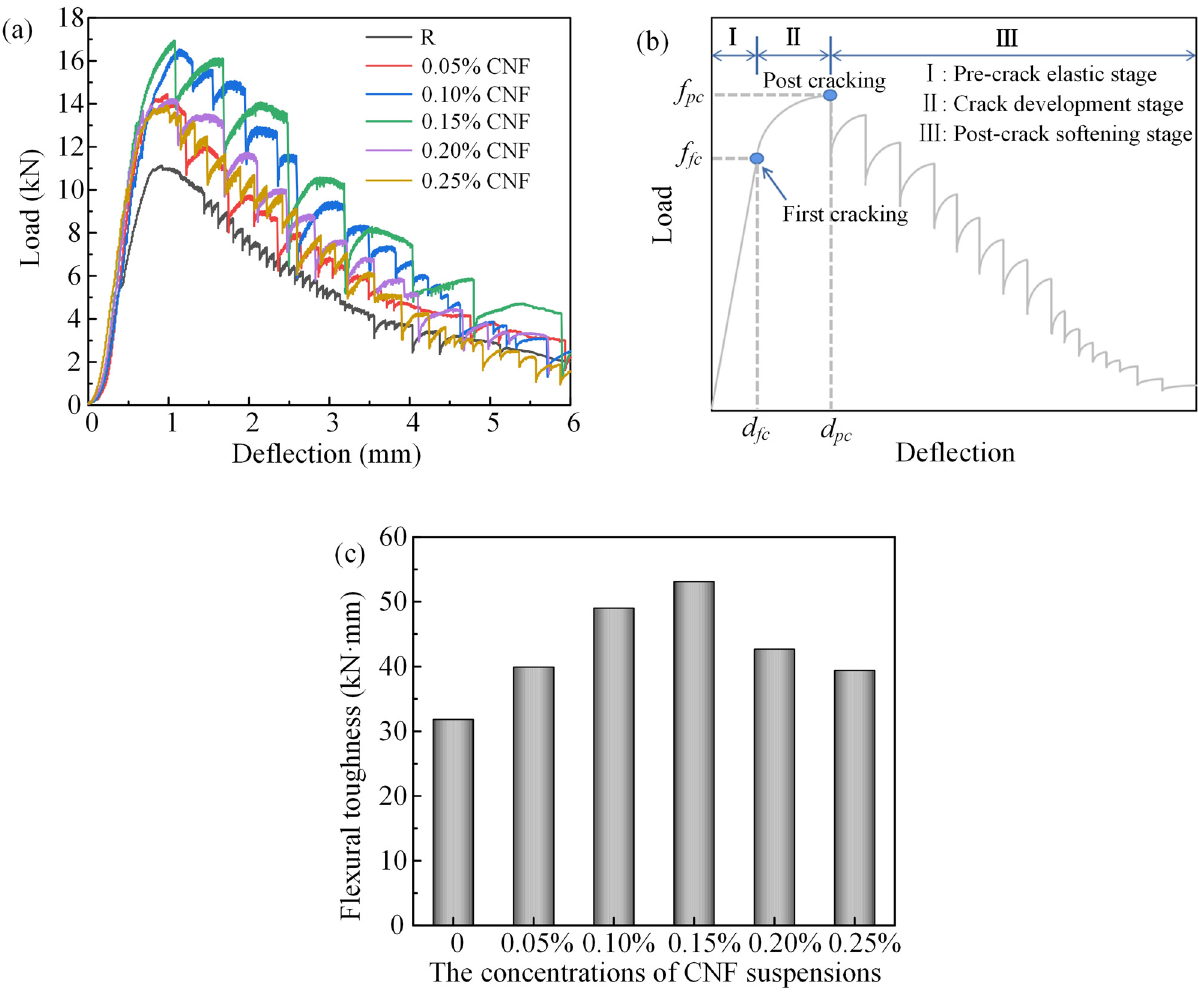
Figure 5: E ff ect of CNF suspensions with various concentrations on fl exural performance: ( a ) load – de fl ection curves of UHPC; ( b ) three